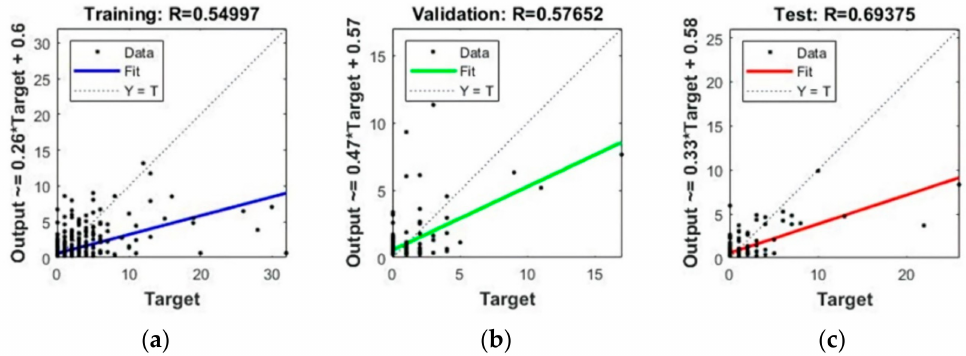
Figure 7. Cluster A model for crime occurrence prediction (layer: 2, node: 7); ( a ) Training data regression result; ( b ) Valida- tion data regression; ( c ) Test data regression result.